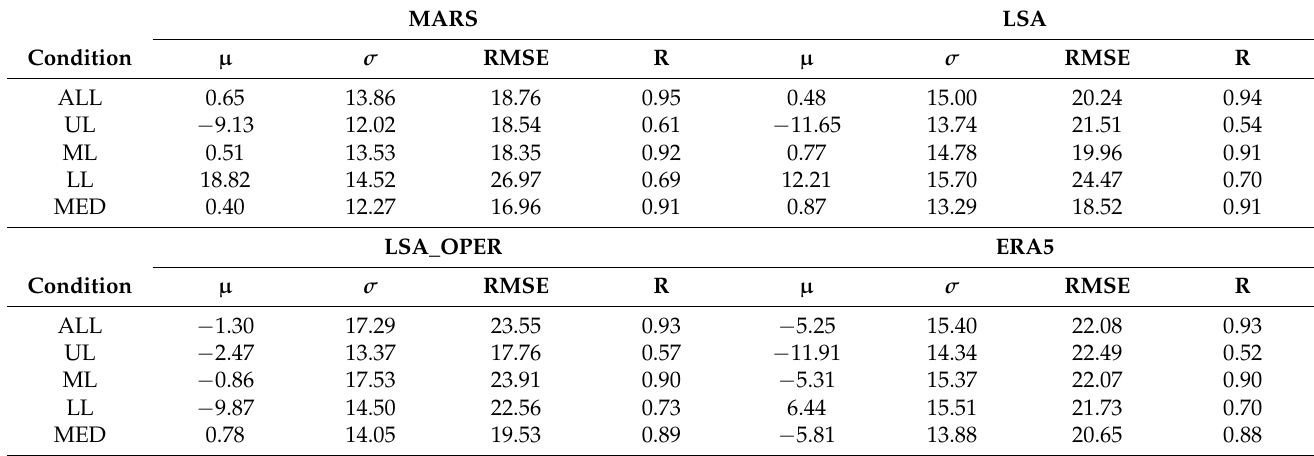
Table 3. Comparison of bias ( µ ), standard deviation of the error ( σ ), root mean square error (RMSE), and temporal correlation coefficient (R) between different models (MARS, LSA, LSA_OPER, and ERA5) and observations from all 23 ground stations for all-sky (2004–2019) in different conditions: considering all data (ALL); observations with values above 400 W · m − 2 (UL); observations with values between 200–400 W · m − 2 (ML); observations with values below 200 W · m − 2 (LL); and the median of the distribution of the metrics computed independently for each station (MED). Units are in W · m − 2 , while correlations are given between 0–1. MARS